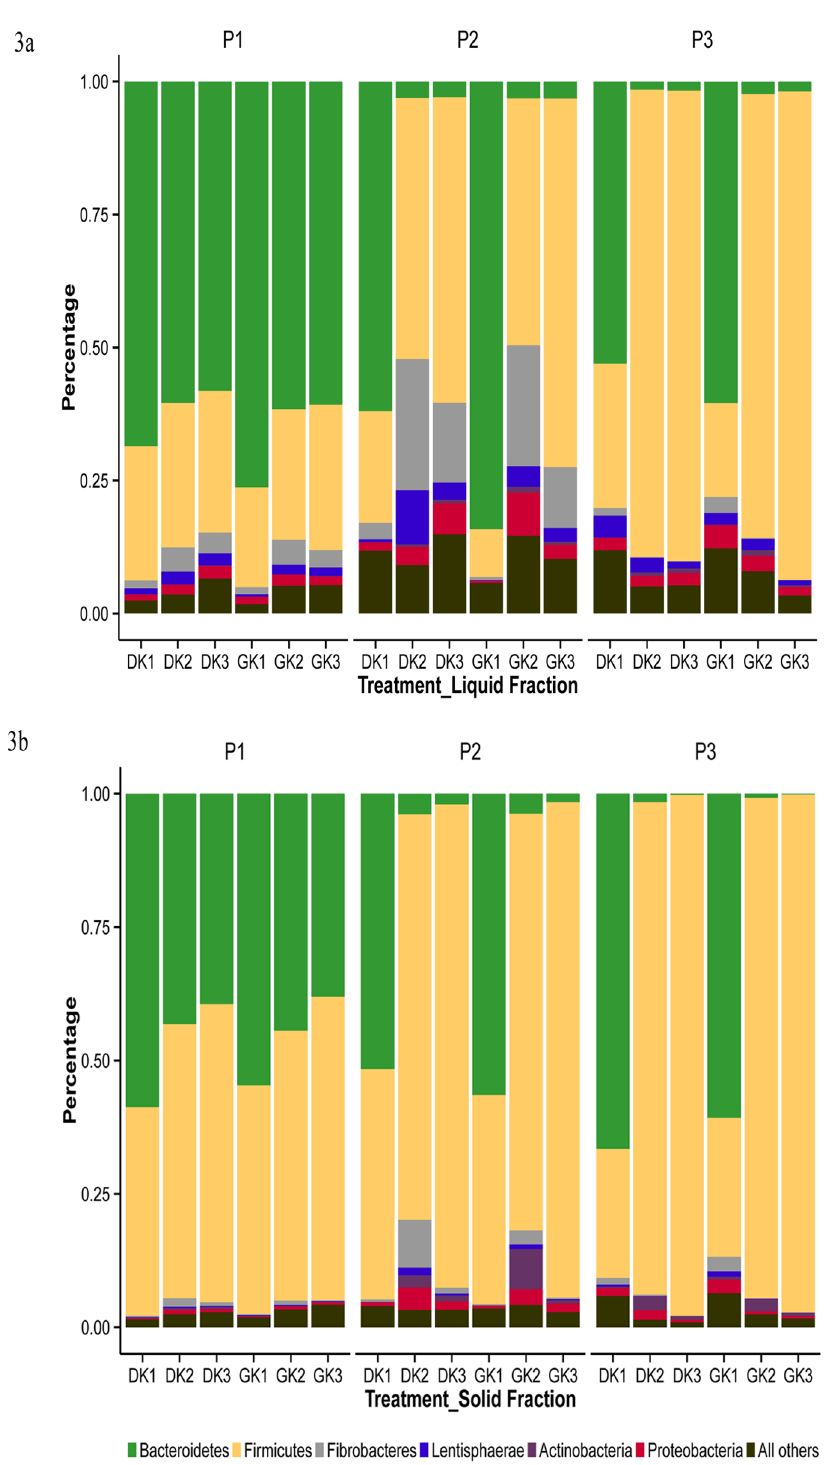
Figure 3. Phylogenetic composition by primer pairs and dietary treatments. Rumen fraction a) liquid; b) solid; Primer pair (P1: targeting V1– V3 region; P2: targeting V4–V5 region and P3: targeting V6–V8 region), treatment: (DK1: 50% dry forage: 50% concentrate; DK2: 75% dry forage: 25% concentrate and DK3: 100% dry forage; GK1: 50% green forage: 50% concentrate; GK2: 75% green forage: 25% concentrate; GK3: 100% green forage) and fraction: solid (S) and liquid